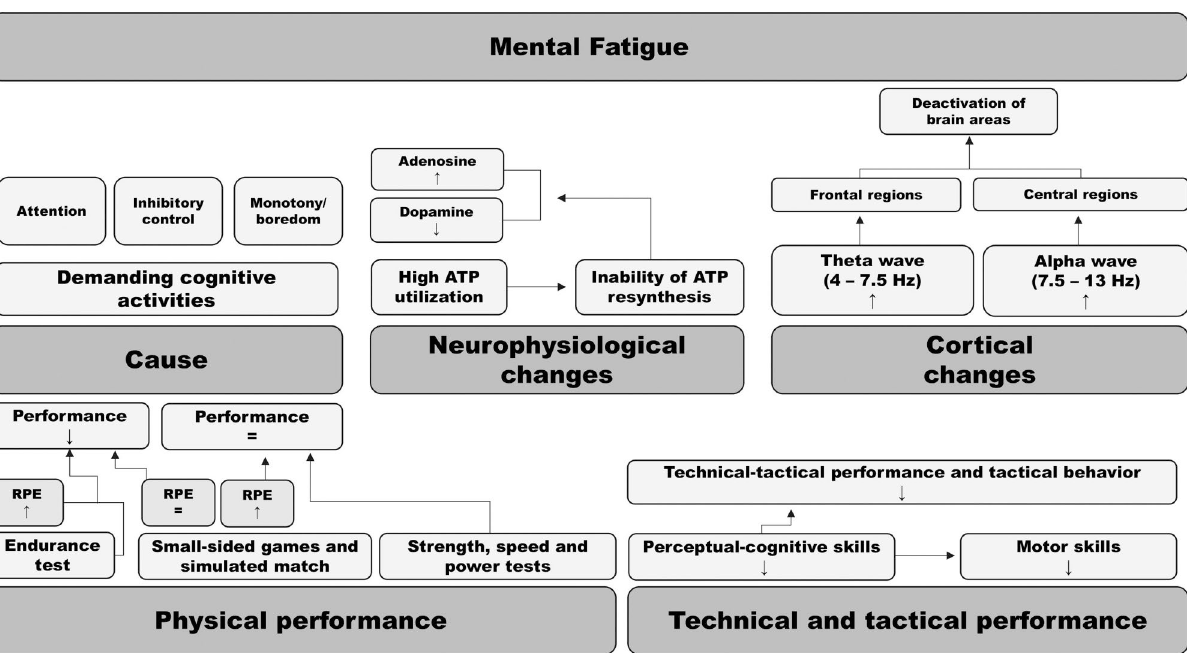
Figure 1 - Conceptual model of mechanisms involved in mental fatigue and effect on performance in ball sports. ↑ increase; ↓ decrease; = remain the